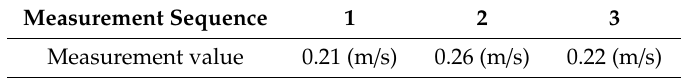
Table 2. The measurement results of the acoustic doppler current profilers (ADCP).